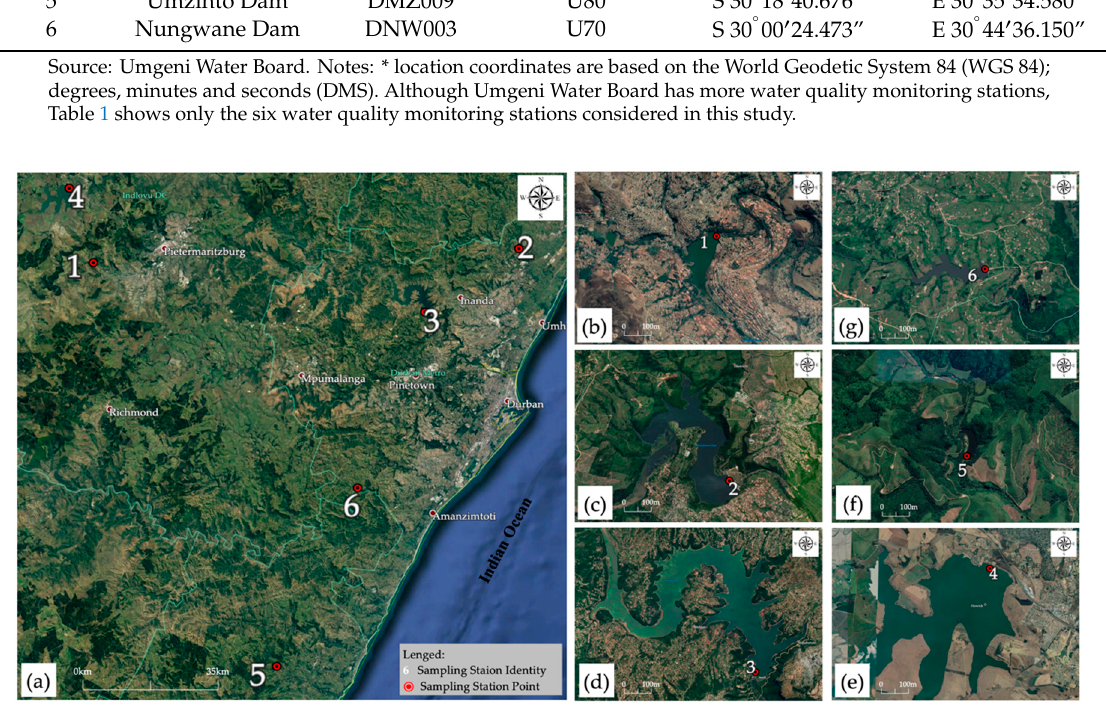
Figure 2. Locality map for sampling stations: ( a ) all six sampling stations, ( b ) Henley Dam, ( c ) Hazelmere Dam, ( d ) Inanda Dam, ( e ) Midmar Dam, ( f ) Umzinto Dam, and ( g ) Nungwane Dam. Source: The underlying map of Figure 2 was downloaded from Google Earth and station coordinates are from Umgeni Water Board (UWB) (Table 1). Sampling station identification numbers: (1) Henley Dam DHL003, (2) Hazelmere Dam DHM003, (3) Inanda Dam DIN003, (4) Midmar Dam DMM003, (5) Umzinto Dam DMZ009, and (6) Nungwane Dam DNW003.